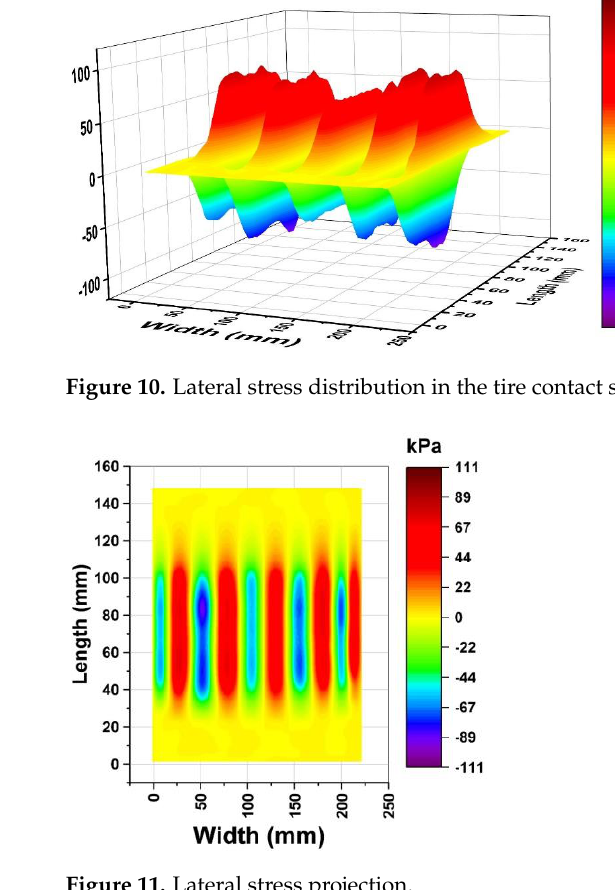
Figure 11. Lateral stress projection.